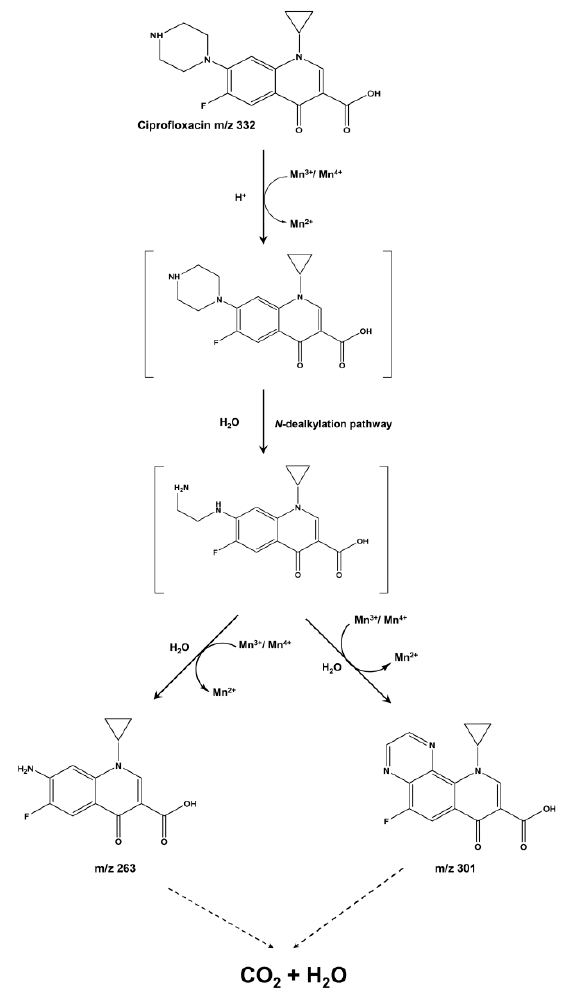
Figure 5. Constructive degradation-metabolic pathway of CIP.